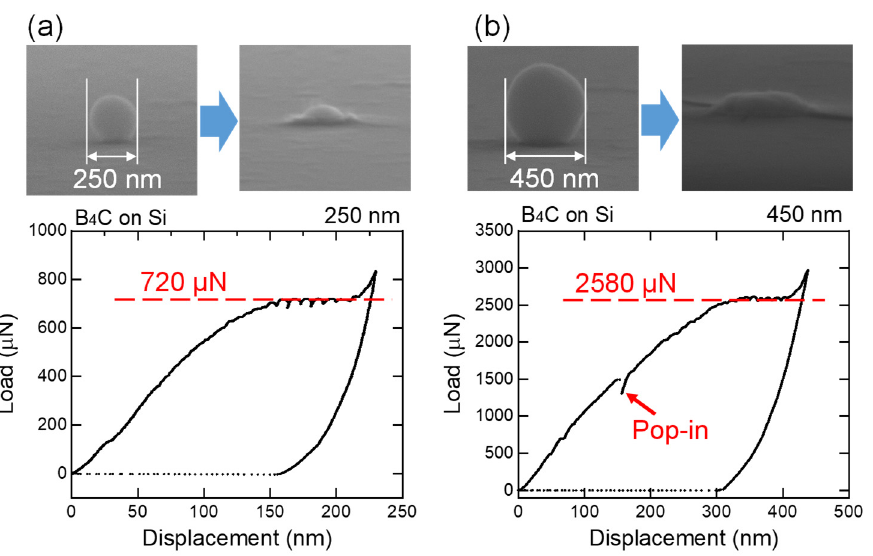
Figure 10. SEM images before and after the load application and load–displacement curves of the particle embedding process for ( a ) 250 and ( b ) 450 nm B 4 C particles in Si substrates.